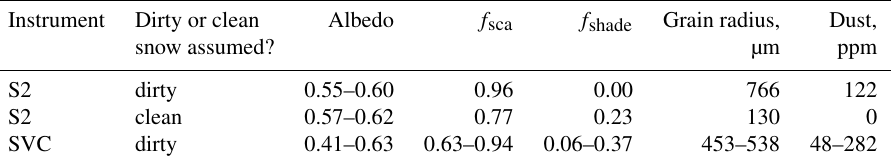
Figure 8. Broadband snow albedo solutions from SPIReS compared to the uncorrected albedo measured at CUES (same as in Fig. 7). In the first set of SPIReS solutions, dirty snow endmembers are used, while in the other the snow is assumed clean. Both sets use a shade endmember. Error bars are ± 0.025 (Bair et al., 2021b). Table 2. Model solutions from SPIReS using measurements from Mammoth Mountain taken on 11 May 2021, the last two points with error bars shown in Fig. 8. The instruments are Sentinel 2B MSI (S2) and the Spectra Vista HR 1024i field spectrometer (SVC). One of the SPIReS runs used a clean-snow assumption to illustrate the difficulty in separating shade from dust endmembers (with low concentrations) with a multispectral instrument. The fractional snow-covered area ( f sca ) and shade ( f shade ) as well as the grain radius and dust concentration are unknowns that are solved for.